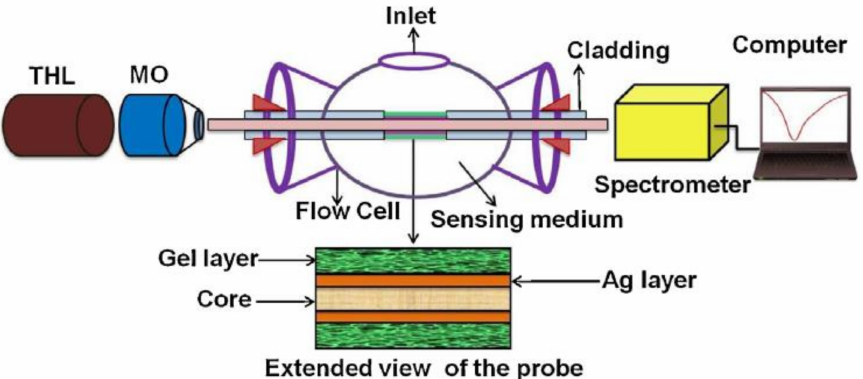
Figure 11. Schematic sketch of the experimental setup of an SPR-based fiber-optic phenol biosensor is shown. The fiber-optic probe is fixed in a small flow cell to enable the delivery and removal of aqueous samples of phenol around the sensing surface. Light from a tungsten–halogen lamp is coupled into the fiber. The spectrum of the transmitted power is recorded by using a spectrometer and a personal computer. (Reprinted with permission from [71]).